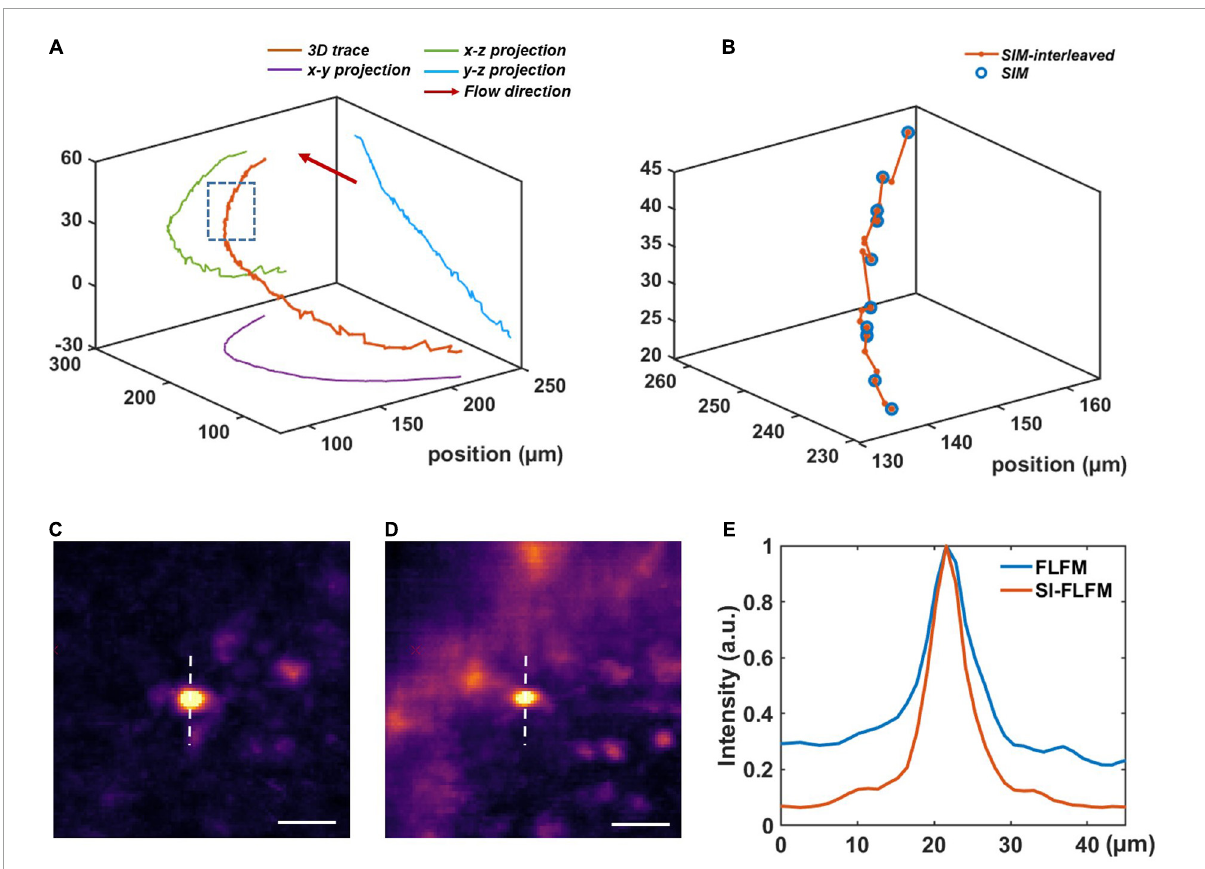
FIGURE4 High-speed blood cell tracking in larval zebrafish in vivo with high SBR. (A) 3D trace of a single blood cell. (B) Enlarged view of the inset box in panel (A) . We can record more positions by using the interleaved reconstruction method. (C,D) Images of the tracked blood cell at t = 22.30 s in SI-FLFM and FLFM modes, respectively. Scale bar: 25 µ m. (E) Comparison between the normalized intensity profiles of the dotted lines in Figures 5C,D